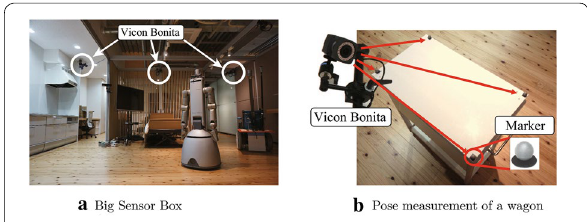
Fig. 3 Optical tracking system (Vicon Bonita) in Big Sensor